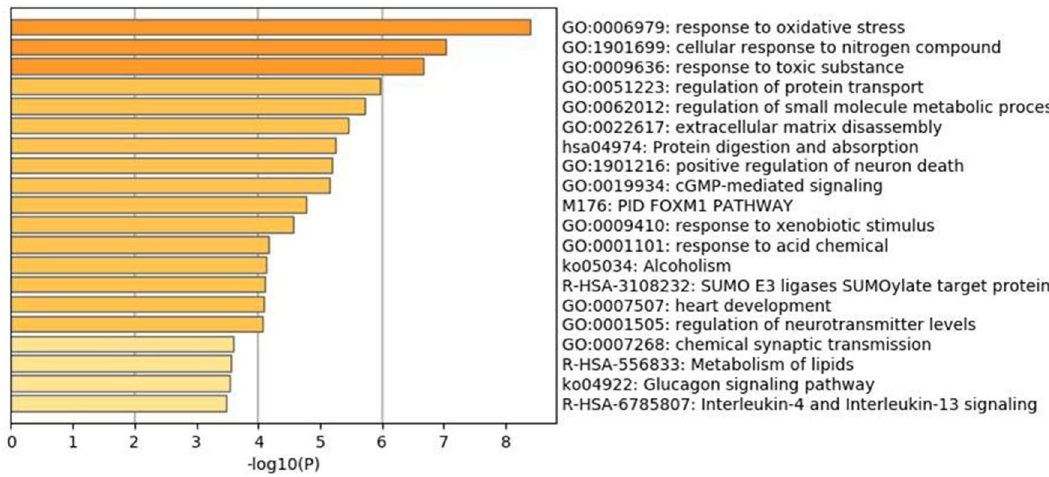
Figure 6. Histogram of Gene Ontology enrichment analysis corresponding to the P- value.